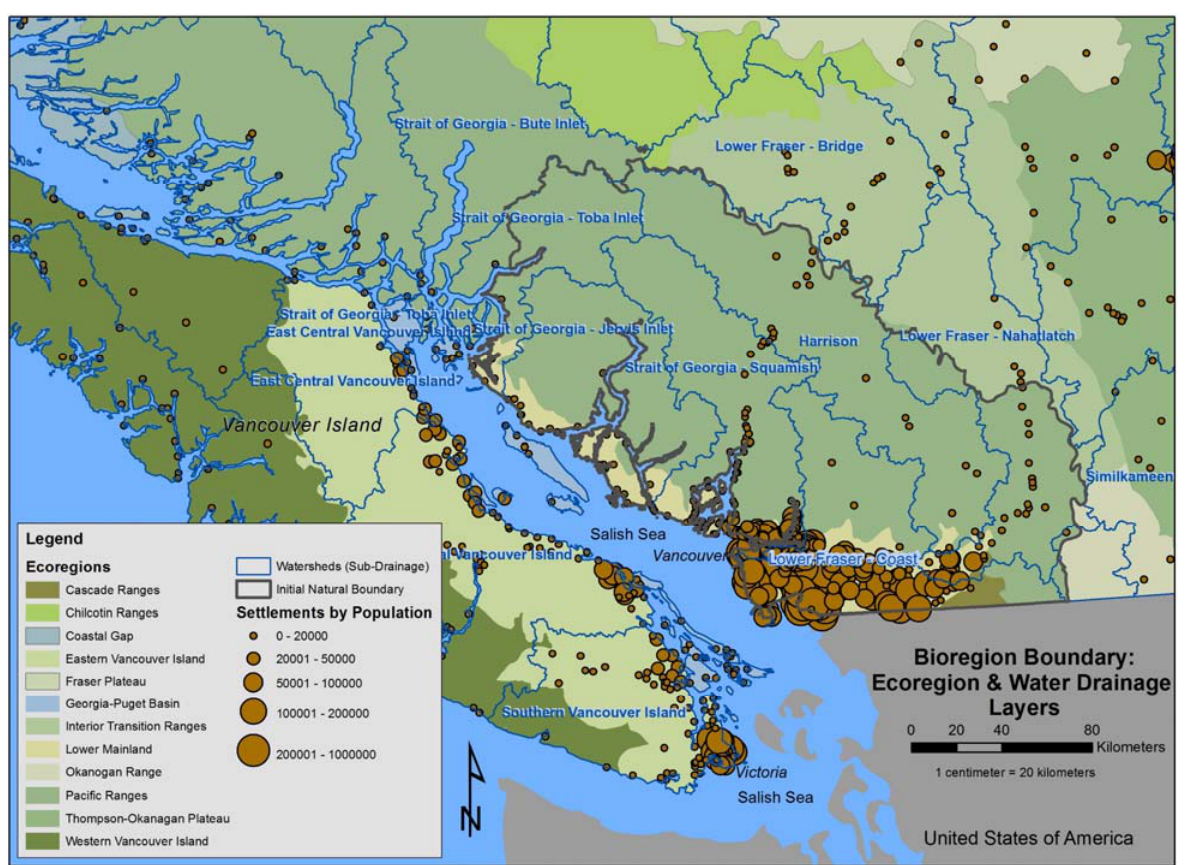
Figure 3. Ecoregion and Water Drainage Areas. These map layers formed the basis for determining the initial natural boundary of the